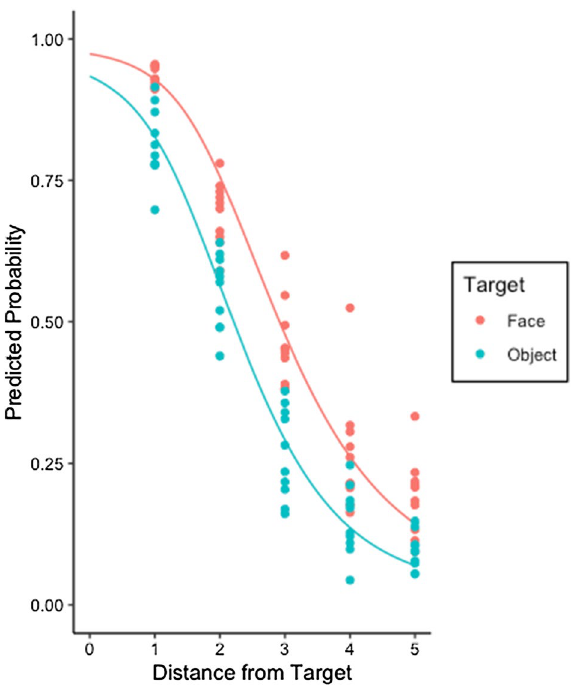
probabilities for each particular